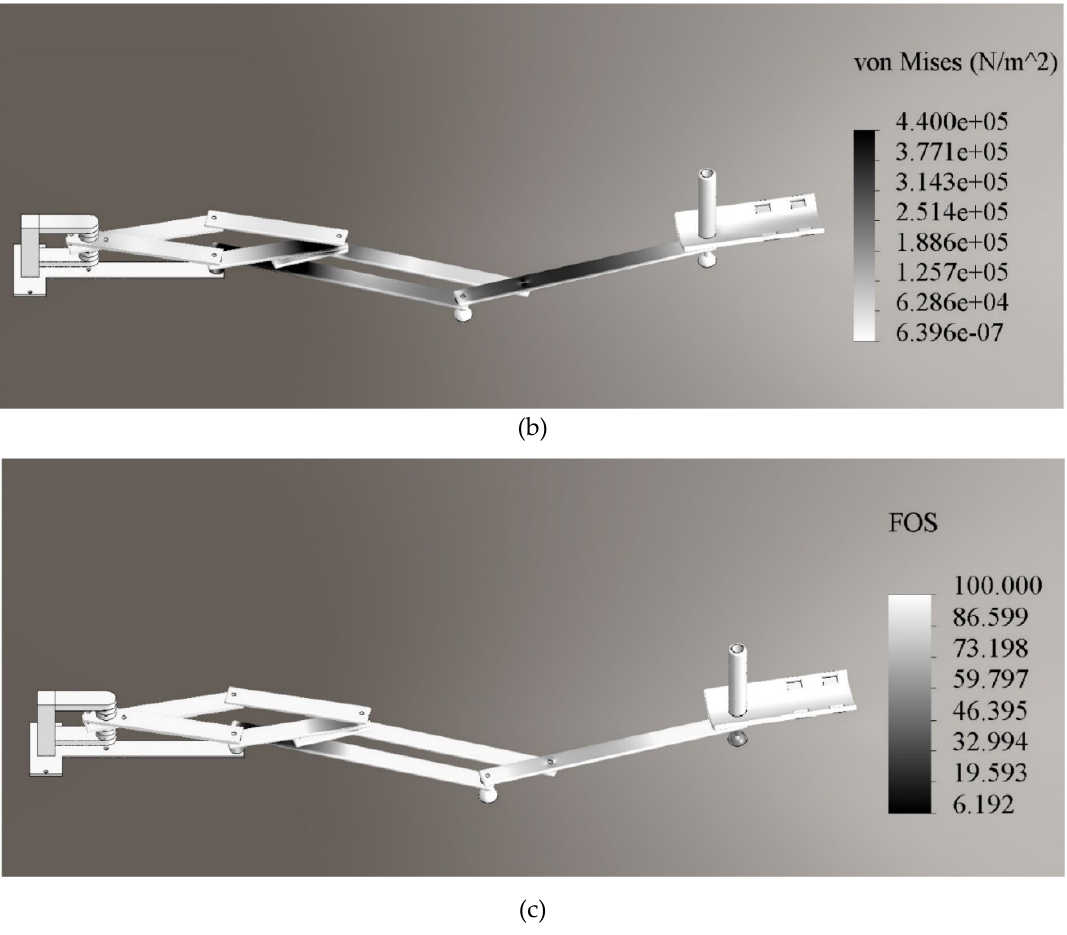
Figure 7. Computed results from FEM analysis: ( a ) Compliant displacement; ( b ) Stress field; and ( c ) Factor Of Safety (FOS).